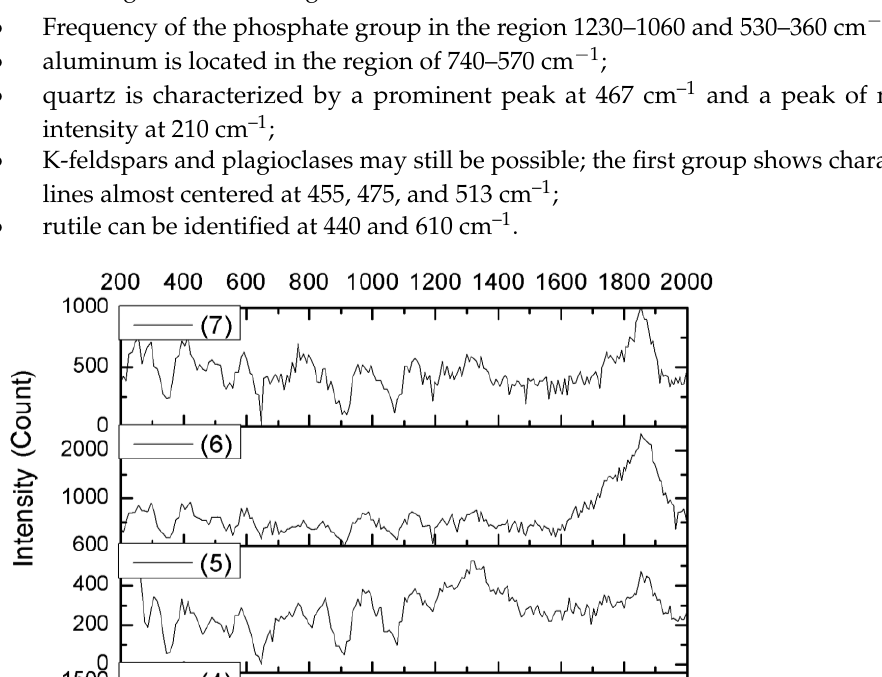
Figure 12. Raman spectra of white powder (blue line) and red ceramic (red line).